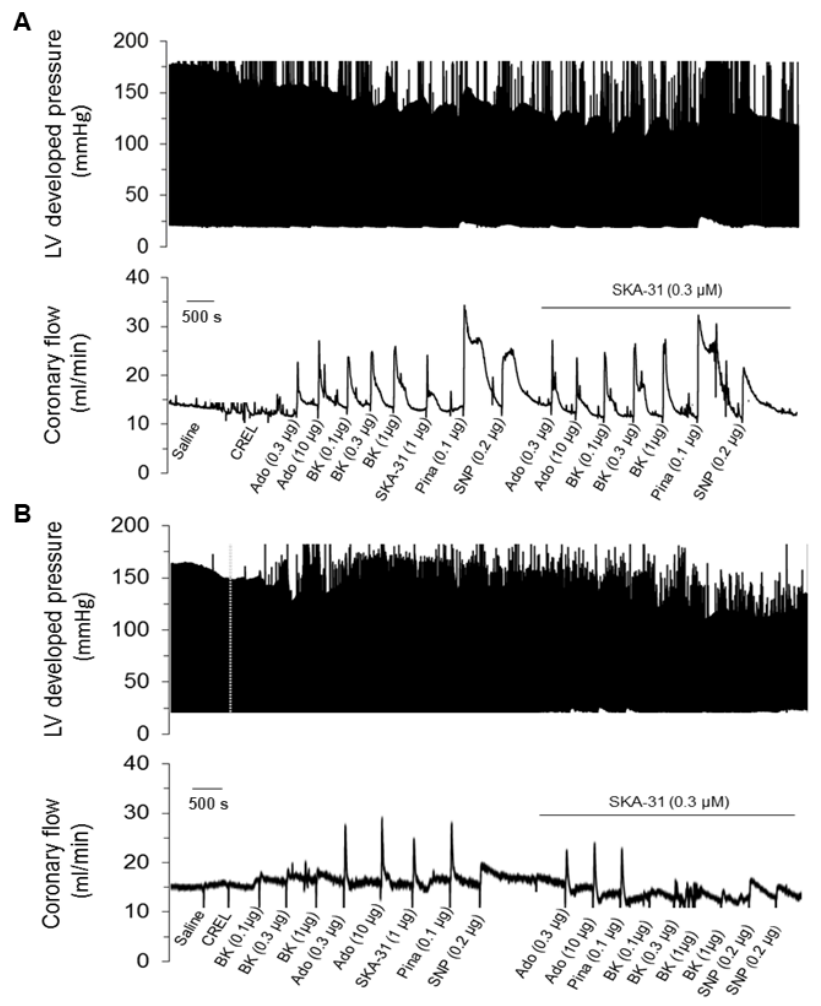
Figure 4. Stimulus-evoked increases in coronary flow are blunted in Langendorff-perfused hearts from SHRs. Panel ( A ) displays representative tracings of LV developed pressure (upper) and coronary flow (lower) in a spontaneously beating, Langendorff-perfused male Wistar rat heart in response to single bolus administrations of saline, drug vehicle (CREL), bradykinin (BK), adenosine (ADO), SKA-31, pinacidil (Pina), sodium nitroprusside (SNP), as denoted below the flow tracing. The repeated administration of these compounds in the presence of 0.3 µ M SKA-31 is indicated by the horizontal bar above the flow tracing. Recordings of LV developed pressure and coronary flow in an isolated, perfused heart from an age-matched male SHR are shown in panel ( B ). Data are representative of 3 – 4 isolated heart preparations from each strain subjected to the same experimental protocol.